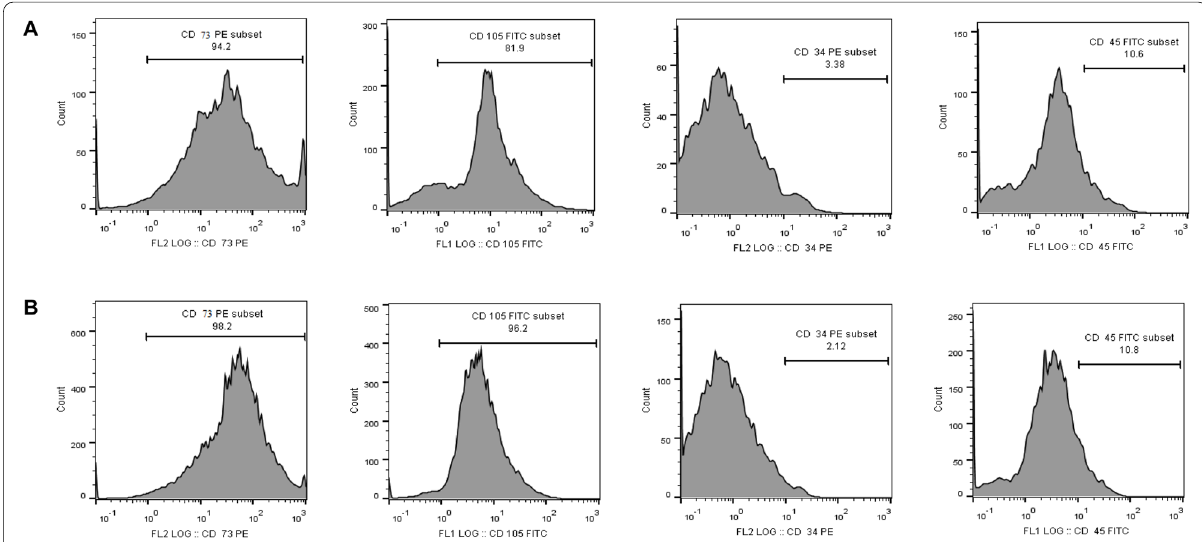
Fig. 3 Flow cytometry analysis of cell surface markers. Mesenchymal stem cell surface markers; CD 73 and CD 105 were positively expressed in both hDPSCs and hPDLSCs whereas hematopoietic markers CD 34 and CD 45 were negatively expressed in both cell